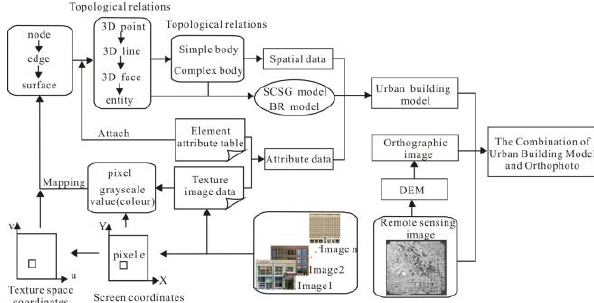
Figure 2. The data organization process of urban building model